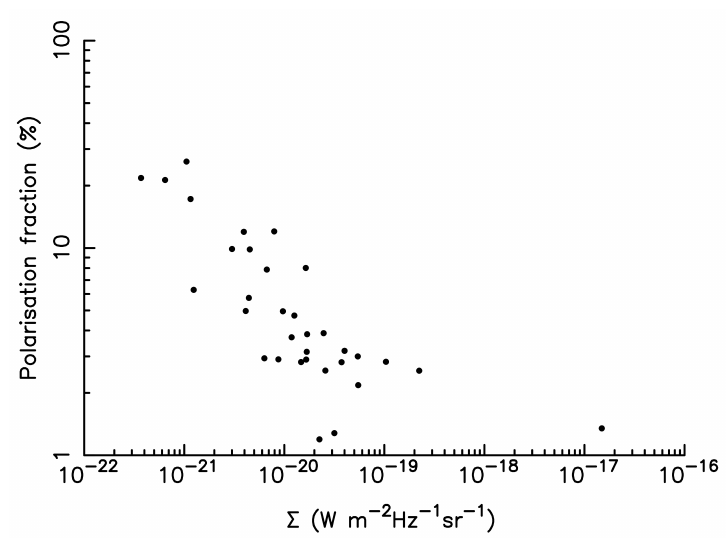
Figure 3. The radio polarisation fraction as a function of the radio surface brightness, taken from [29] and based largely on the sample in [33]. Surface brightness is here a proxy for size and/or age; low surface brightness remnants tend to be larger and older. So this plot shows that young SNRs have low polarisation fractions (few % to